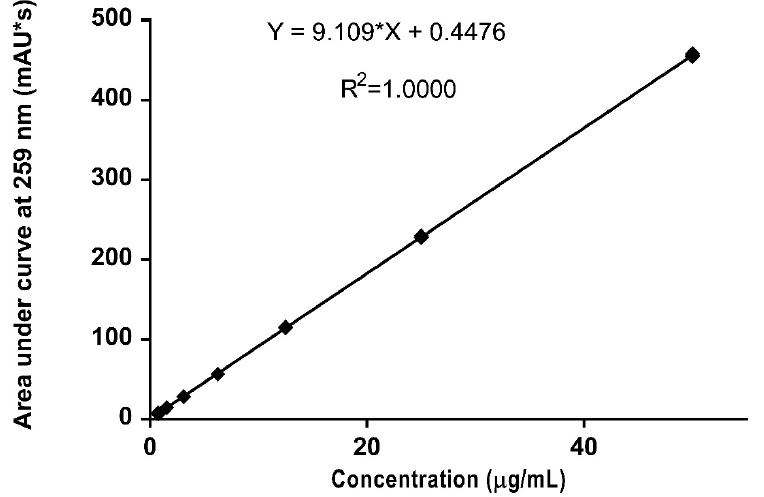
Figure 3. Mean standard HPLC calibration curve of nicotine showing linearity over a concentration range of 0.78–50 μ g/mL ( n = 5, data points indicate mean values and error bars represent standard deviations).